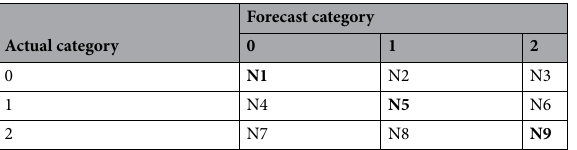
Table 1. Error matrix used for the accuracy assessment. 0, 1, 2 are dependent variables respectively; N1 means the actual category is 0, the forecast category is 0, and so on.